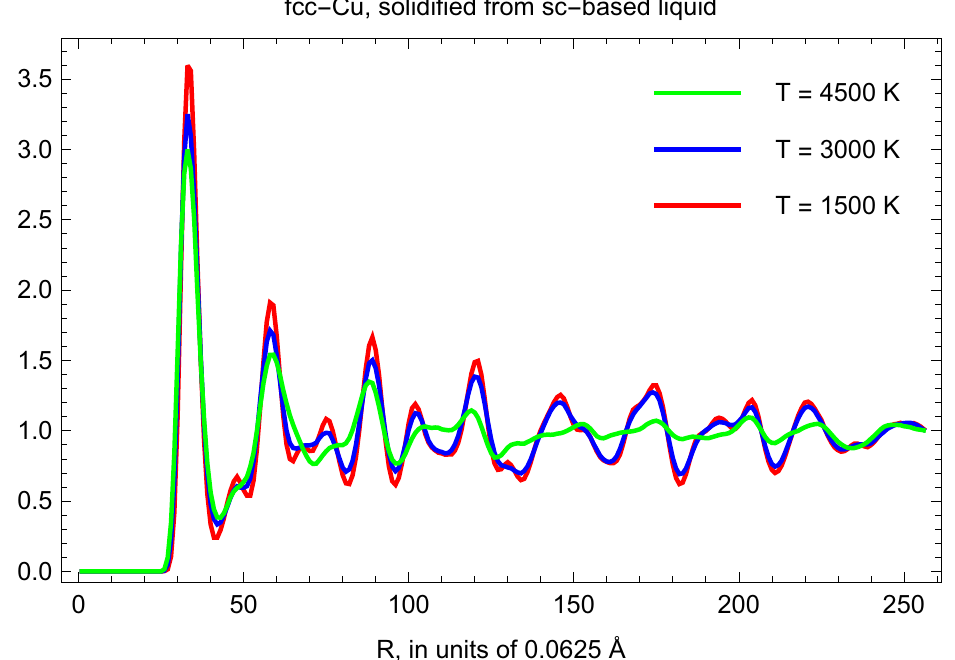
Figure 5. Radial distribution functions (RDFs) of the final states of the solidification of liquid Cu at ∼ 400 GPa at lower